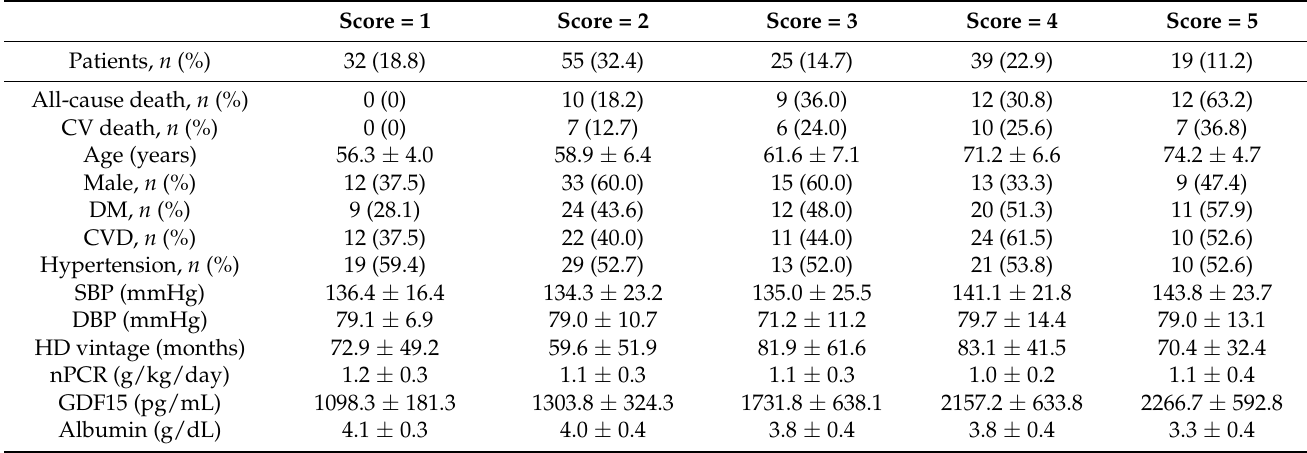
Table 4. Comparison of bio-clinical parameters and fatal events according to GDF15-based risk score system in the whole study